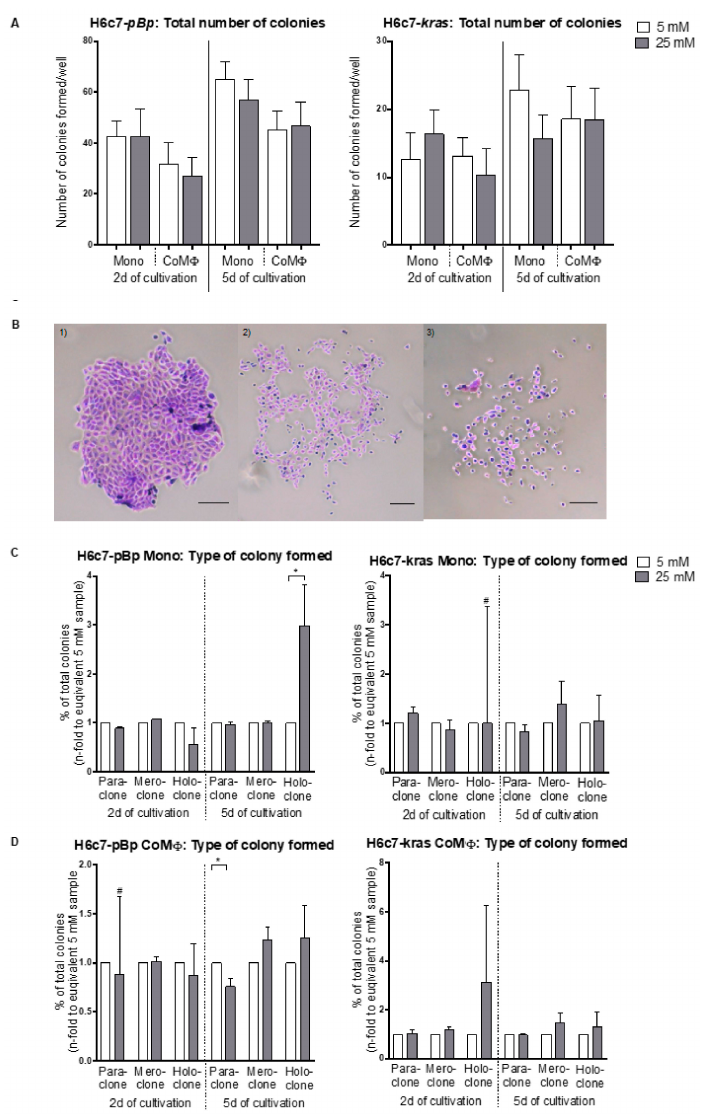
Figure 4. Impact of macrophages and hyperglycemia on the colony formation ability of PDEC. H6c7- pBp or H6c7- kras cells were cultivated in normo- or hyperglycemic conditions (5 or 25 mM of D -glucose) in mono- or coculture with M1-polarized macrophages (M Φ ) for either 2 or 5 days. The epithelial cells were separated from direct coculture with macrophages via CD11b-MACS depletion of M1-M Φ or harvested from monoculture and used for colony formation assays. For this, 800 cells/well were seeded in duplicates and cultivated for further 8 to 14 days. After fixation and staining, colonies of more than 50 cells were analyzed. The total number of colonies per well formed by PDEC arising from short- or long-term mono- or coculture are shown in ( A ). In ( B ) representative pictures of a (1) holo-, (2) mero- and (3) paraclone formed by H6c7- pBp cells are shown. The scale bar = 100 µ m. The quality of colonies arising from mono- ( C ) or cocultured ( D ) PDEC after short- or long-term cultivation are shown for both cell lines. ( C , D ) Data are depicted as n -fold to the equivalent sample arising from normoglycemic settings and short-term cultivation. Normally distributed data are presented as mean and standard error of mean; not normally distributed data (indicated via #) are shown as median and interquartile range. * 0.05 > p > 0.0332; n = 4 for 2-day culture; n = 7 for 5-day